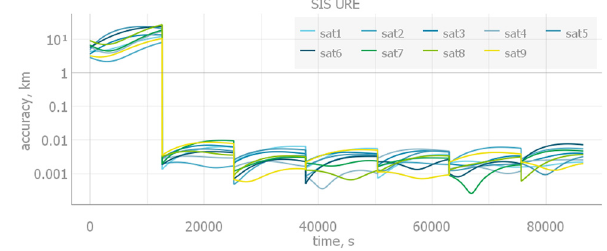
Figure 7: On - board LNSS orbit determination with astro - measure - ments, the measurement interval is 3.5